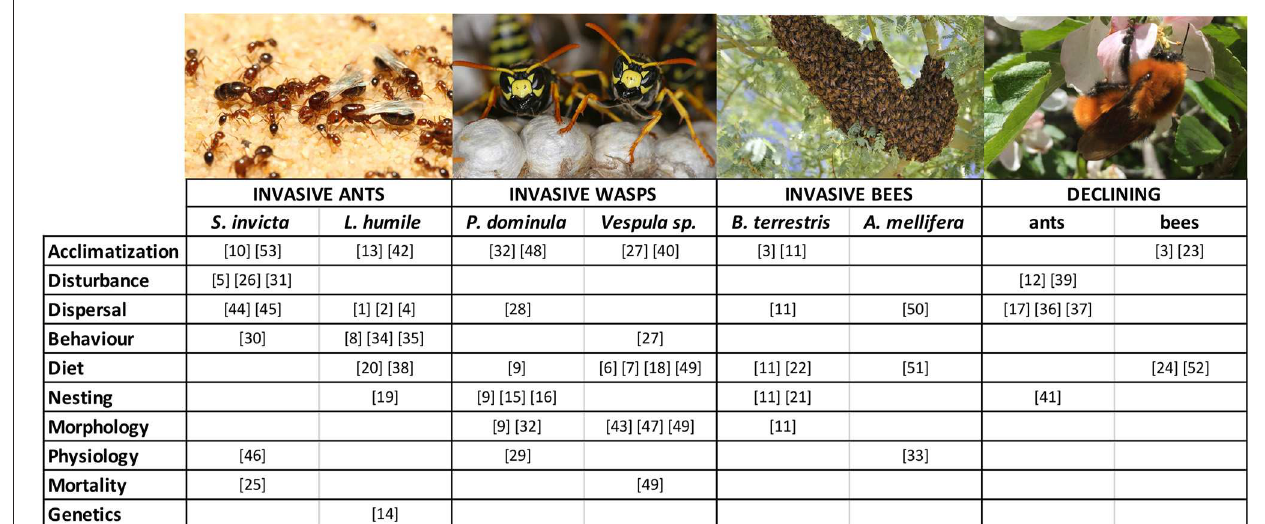
FIGURE 2 | Summary of research studies (to date) that have investigated traits that show the potential for plasticity (or lack thereof) in association with invasions or declines of various taxa of social insects. The traits reported in the figure are the same as discussed in the main text (with the relevant references). Individual traits have been classified and clumped together according to broadly defined macro-categories in line with what reported for other organisms (sections Phenotypic plasticity in various traits as facilitators of biological invasions and Limited phenotypic plasticity in the context of species declines). Some macro-categories include traits that are highly relevant/specific for social insects: “Dispersal” includes range of mating flights, colony founding strategy, time of queens emergence from diapause and time of release of sexuals; “Behavior” includes intraspecific competition for food resources; “Morphology” includes colony size; “Mortality” refers to individual mortality of single insects. Pictures shown above are (from left to right): the fire ant Solenopsis invicta , the paper wasp Polistes dominula , the Africanized honey bee Apis mellifera , and the bumble bee Bombus dahlbomii (Photo credits: Wikimedia Commons, except bumble bee by Amy Toth).